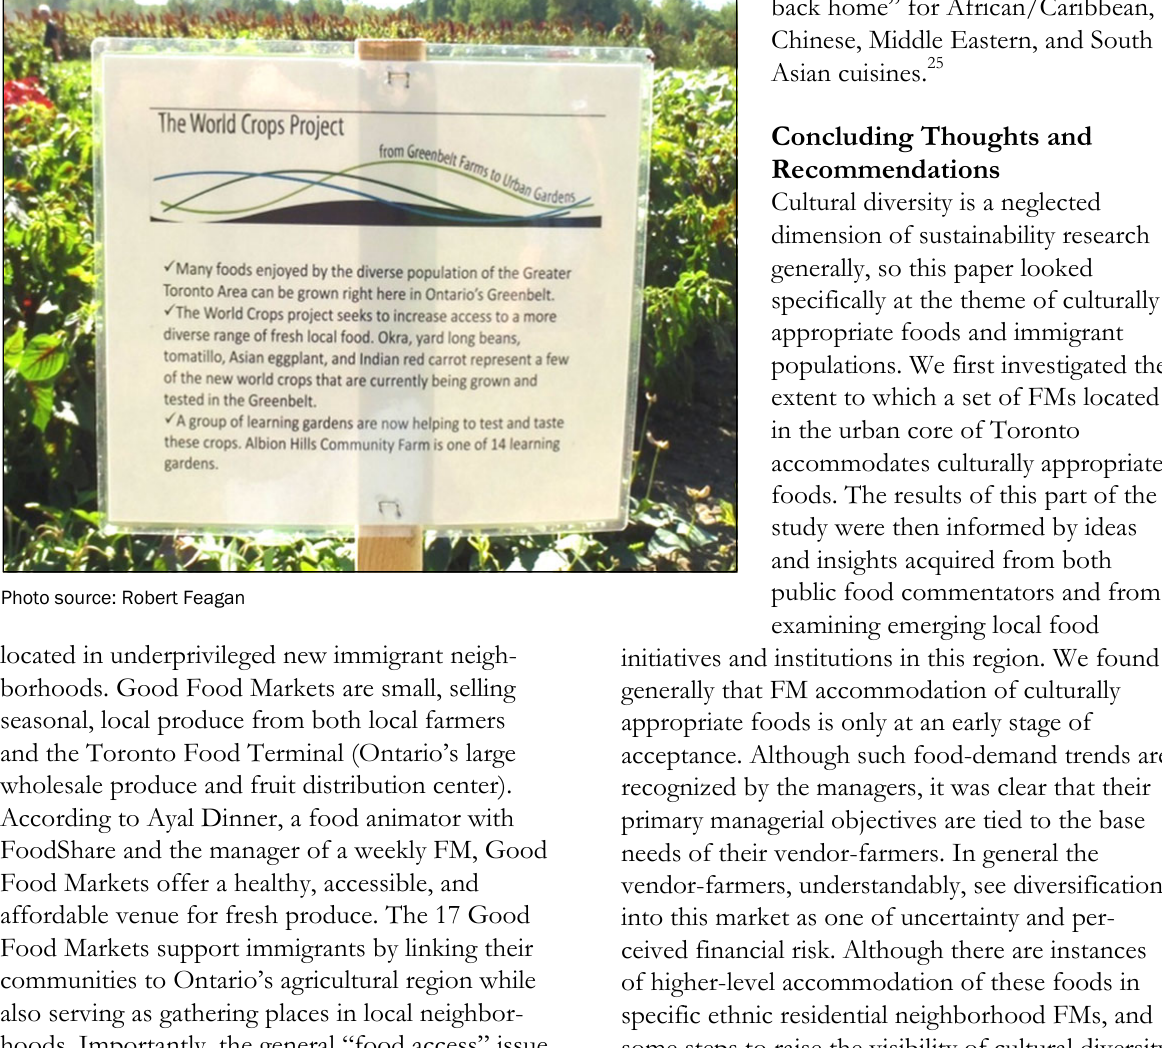
Figure 2. Pilot Project with Culturally Appropriate Foods